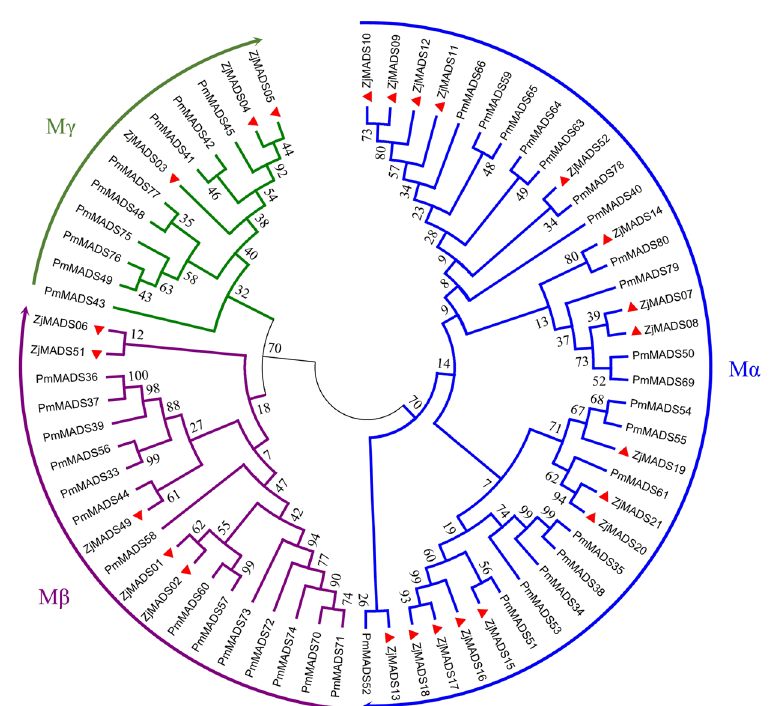
Figure 1. Phylogenetic tree of Z . jujuba and P . mume type I MADS-box genes. The phylogenetic tree was constructed based on the alignable region of protein sequence alignment of Chinese jujube MADS-box genes using the neighbor-joining method and no of differences model with bootstrapping analysis (1000 replicates). The subgroups are marked by different